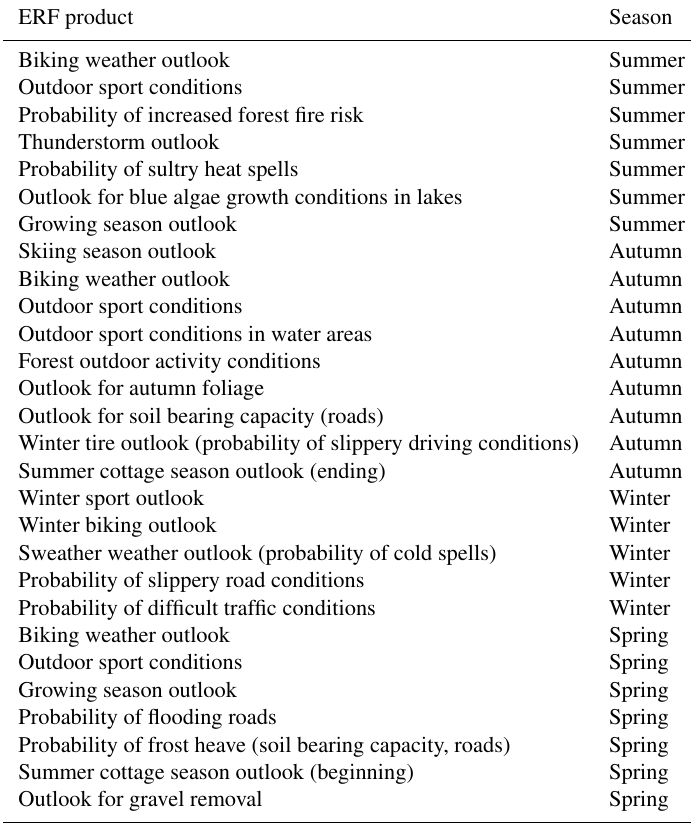
Table A1. Product portfolio of the possible tailored extended-range forecasts presented in the CLIPS online